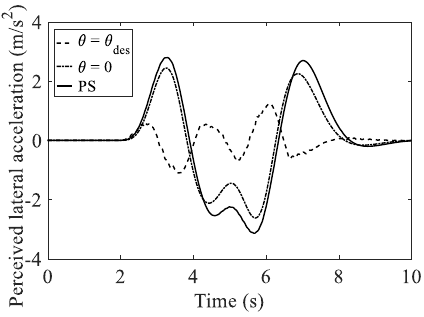
Figure 21. Lateral load transfer ratio. Figure 20. Perceived lateral acceleration. Figure 20. Perceived lateral